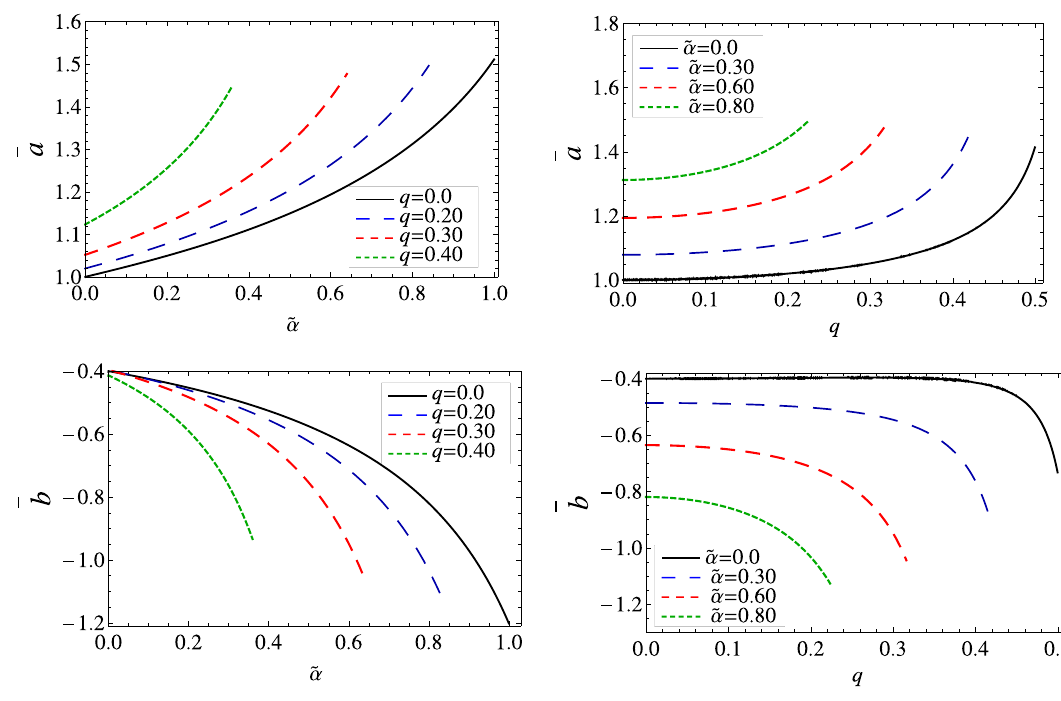
Fig. 6 Plot showing the behavior of strong lensing coefficients ¯ a and ¯ b as a functions of ˜ α (Left Panel) and q (Right